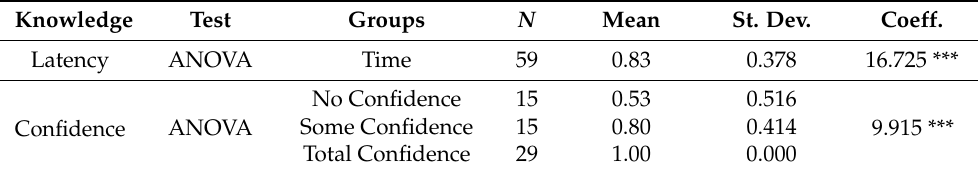
Table 2. Bivariate Analysis of